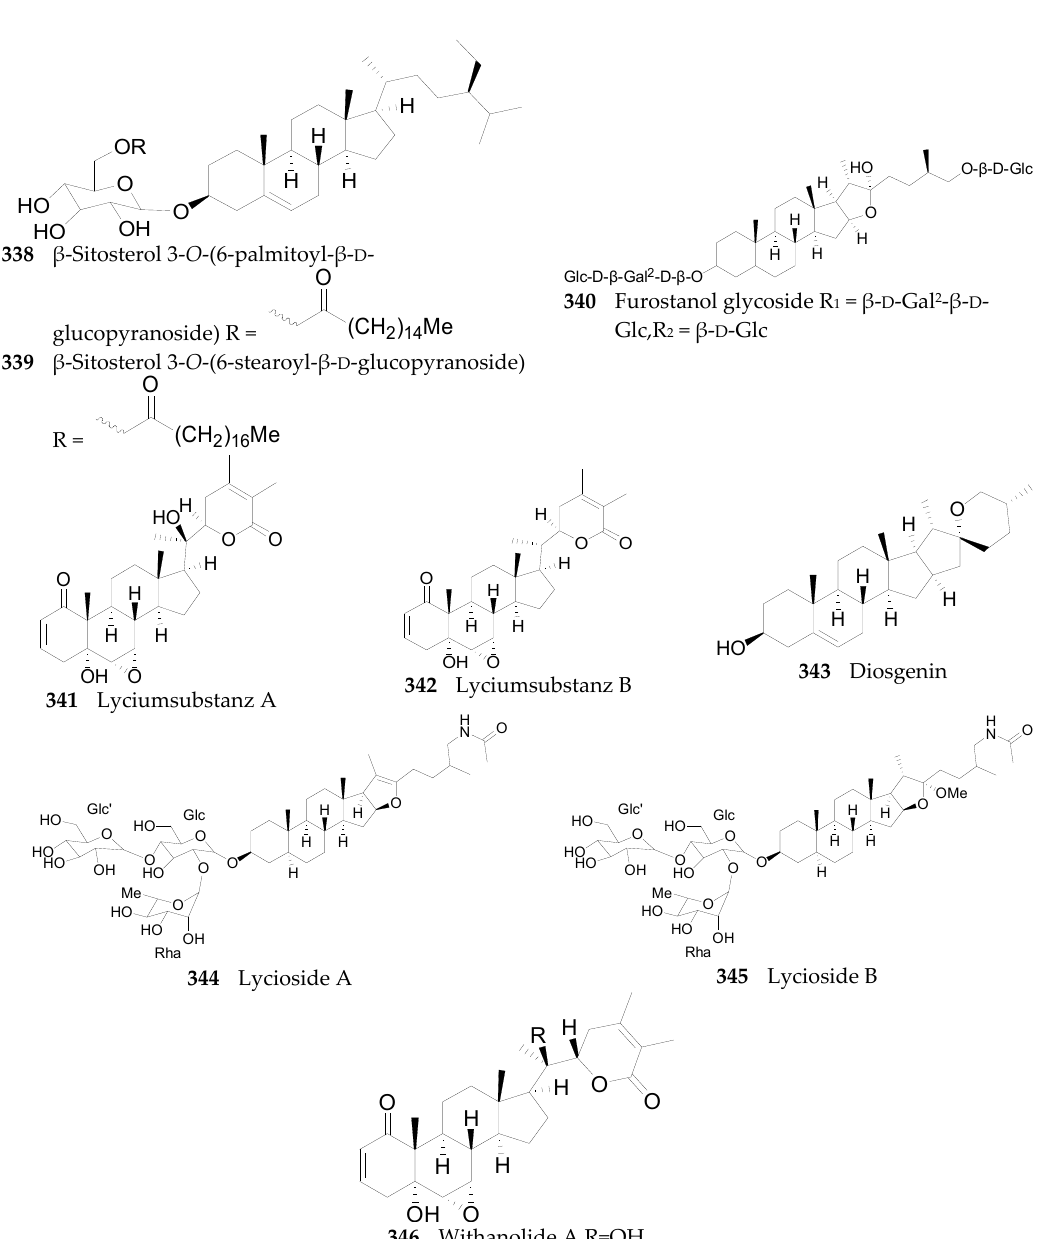
Figure 22. Chemical structures of compounds 291 – 347 .